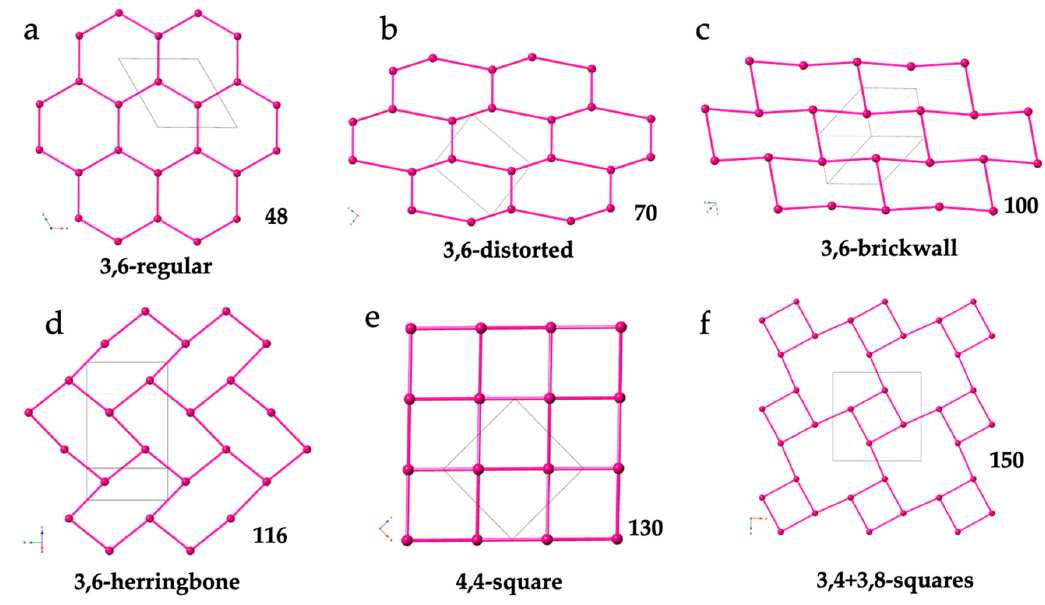
Figure 4. Schematic views of the di ff erent 2D lattices found in Ln-anilato compounds: ( a ) View of the (3,6) lattice with regular hexagons in 48 . ( b ) View of the (3,6) lattice with distorted hexagons in 70 . ( c ) View of the (3,6) lattice with rectangular rings in a brick ‐ wall structure in 100 . ( d ) View of the (3,6) lattice with rectangular rings in a herringbone structure in 116 . ( e ) View of the (4,4) lattice in 130 . ( f ) View of the (3,4)+(3,8) lattice in 150 . Only the Ln(III) ions are displayed for clarity. The pink bonds represent the anilato bridges. The 4,4 ‐ gon topology (Figure 4e) is observed in a total of twenty compounds ( 130 ‐ 149 , Table 6). In these 2D lattices, each Ln(III) is connected to four Ln(III) ions by anilato bridges giving rise to square rings that form a chessboard square structure.